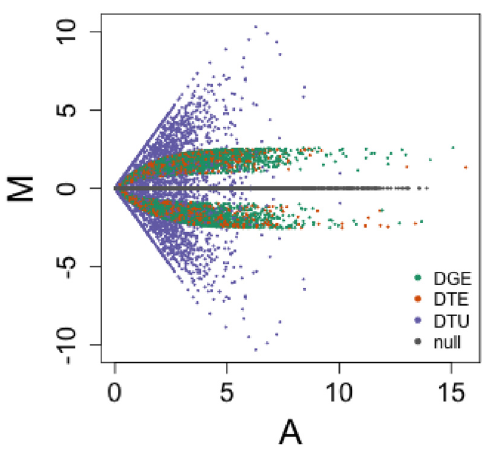
Figure 2. MA plot of simulated abundances. Each point depicts a transcript, with the average log2 abundance in transcripts-per-million (TPM) on the x-axis and the difference between the two groups on the y-axis. Of the 35,850 transcripts which are expressed with TPM > 1 in at least one group, 77% (n=27,429) are null transcripts (grey), which fall by construction on the M=0 line, and 23% (n=8,421) are differentially expressed (green, orange, or purple). This filtering of 1 TPM is for visualization only and unrelated to the DRIMSeq filtering used in the workflow. As transcripts can belong to multiple categories of differential gene expression (DGE), differential transcript expression (DTE), and differential transcript usage (DTU), here the transcripts are colored by which genes they belong to (those selected to be DGE-, DTE-, or